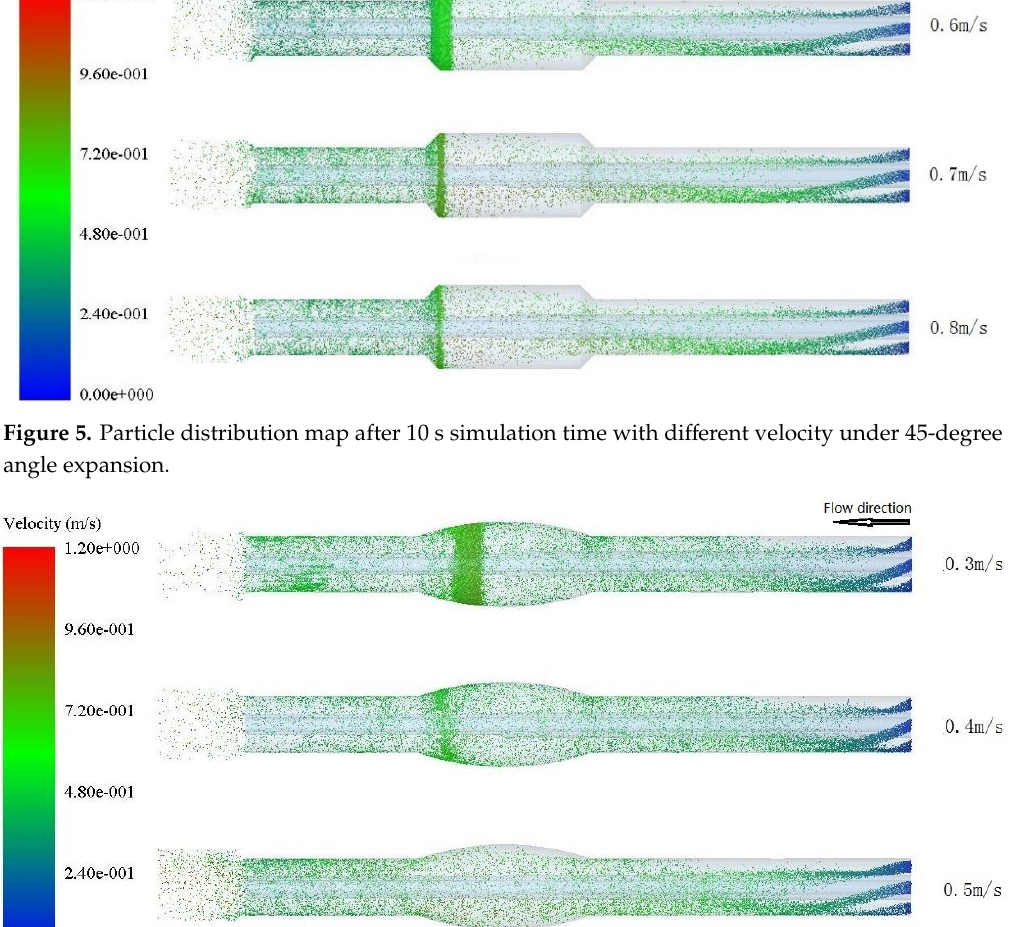
Figure 6. Particle distribution map after 10 s simulation time with different velocity under arc